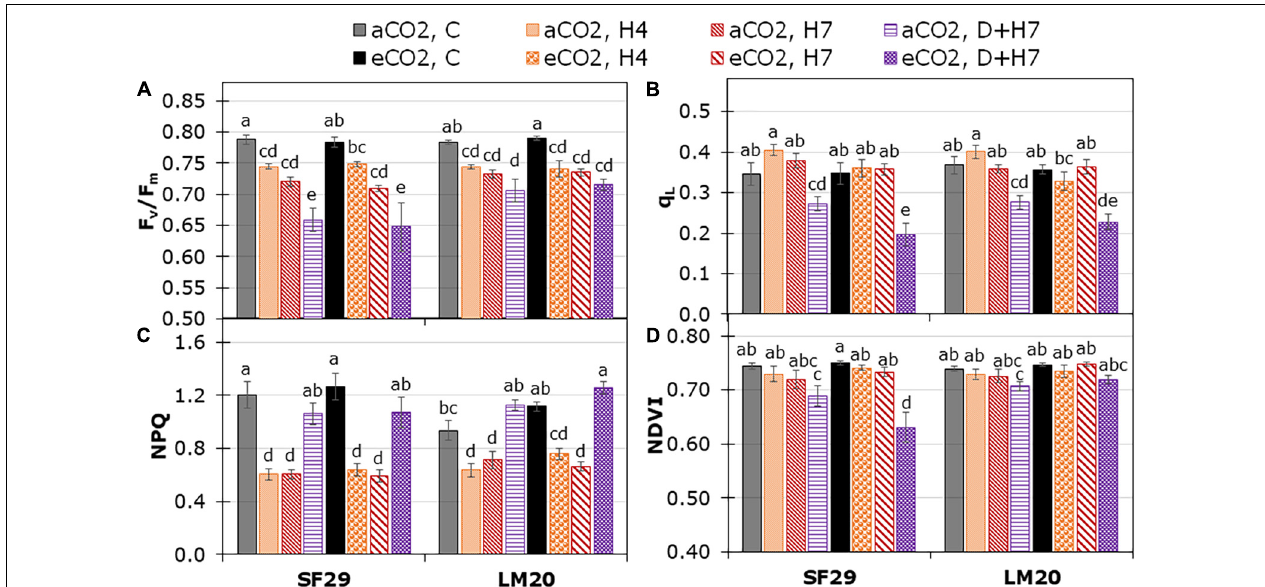
FIGURE 3 | Chlorophyll fluorescence parameters; (A) the maximum quantum efficiency of PSII (F v /F m ) on dark-adapted leaves, (B) fraction of open PSII centers (q L ) and (C) non-photochemical quenching (NPQ), and the leaf reflectance represented as (D) normalized difference vegetation index (NDVI) in heat-sensitive (SF29) and heat-tolerant (LM20) genotypes grown under control conditions (C), heat stress at Day 4 (H4), at day D (H7), and combined heat stress and drought at Day 7 (D + H7) at ambient CO 2 (aCO 2 ) or elevated CO 2 (eCO 2 ). The data represent mean values ± standard error (S.E.) ( n = 6–8). Different small letters indicate significant differences within variants according to Duncan’s test after ANOVA ( p <